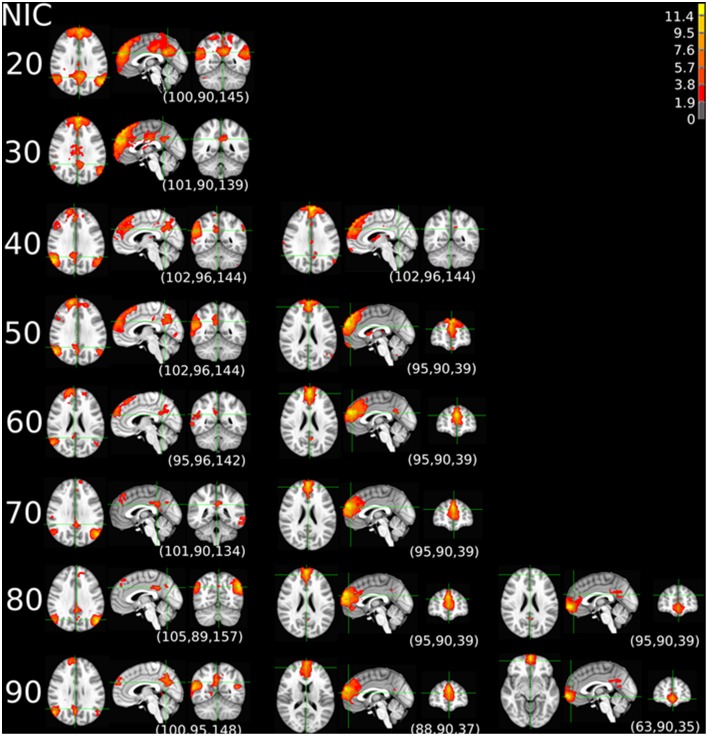
The tracking results of dataset 4 for a typical RFN through similarity matching. The primary visual functional network was tracked at NIC = 20–90. The IC did not split in the entire investigated NIC range.